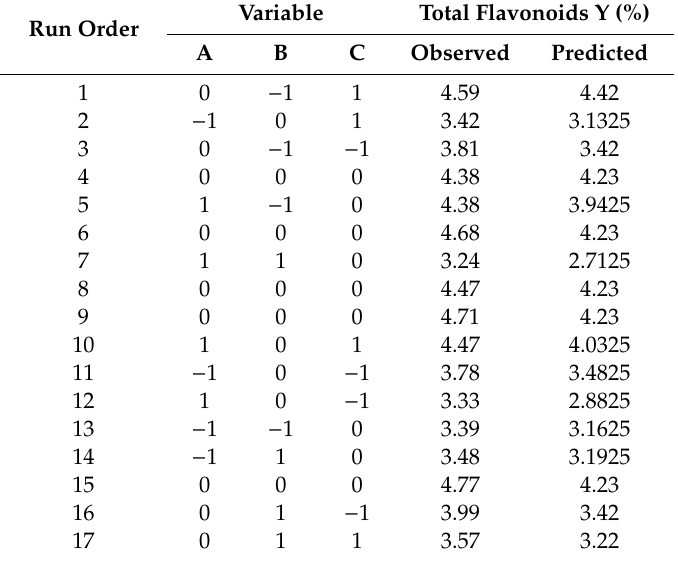
Table 2. Experimental design and results for response surface analysis. A, B, and C are extraction time, alcohol content, and ratio of liquor to material ( v / w ), respectively.